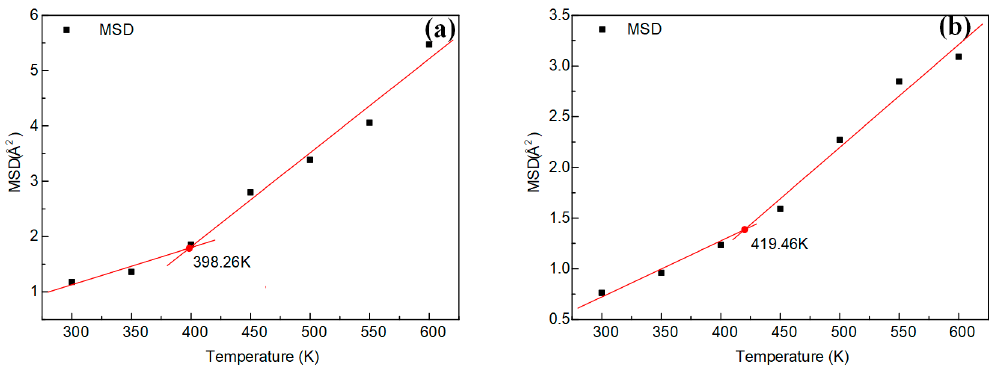
Figure 10. The MSD (15 ps)-temperature fitting curves of epoxy resins. ( a ) DGEBA-MTHPA; ( b ) DGEBA-NA.